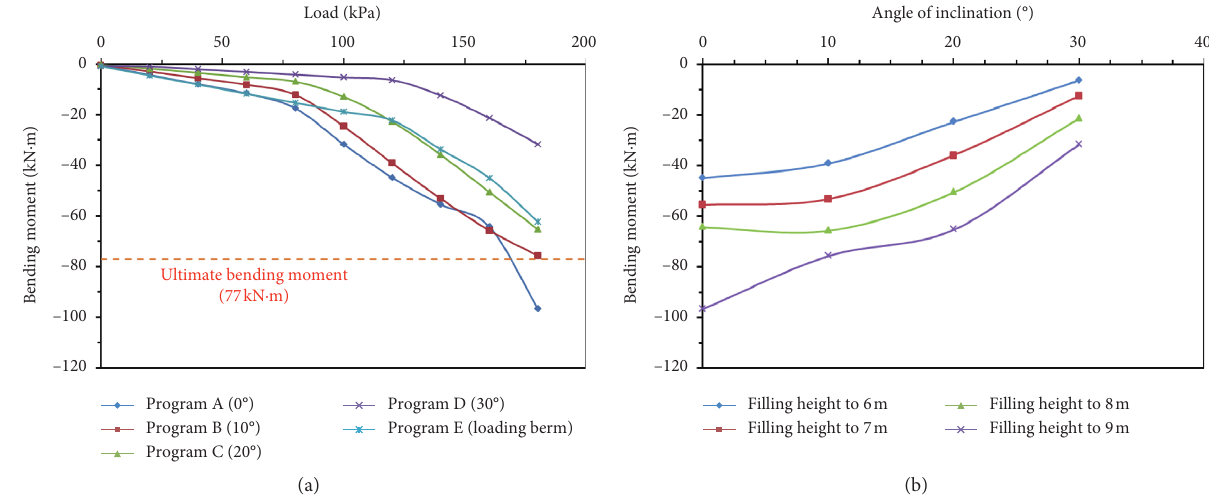
Figure 14: Variations of the maximum bending moments. (a) Change with loads and (b) change with inclination